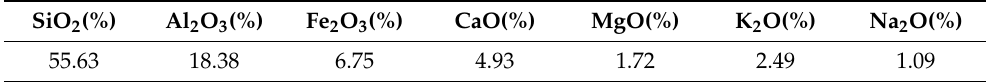
Table 1. Composition and content of the fly